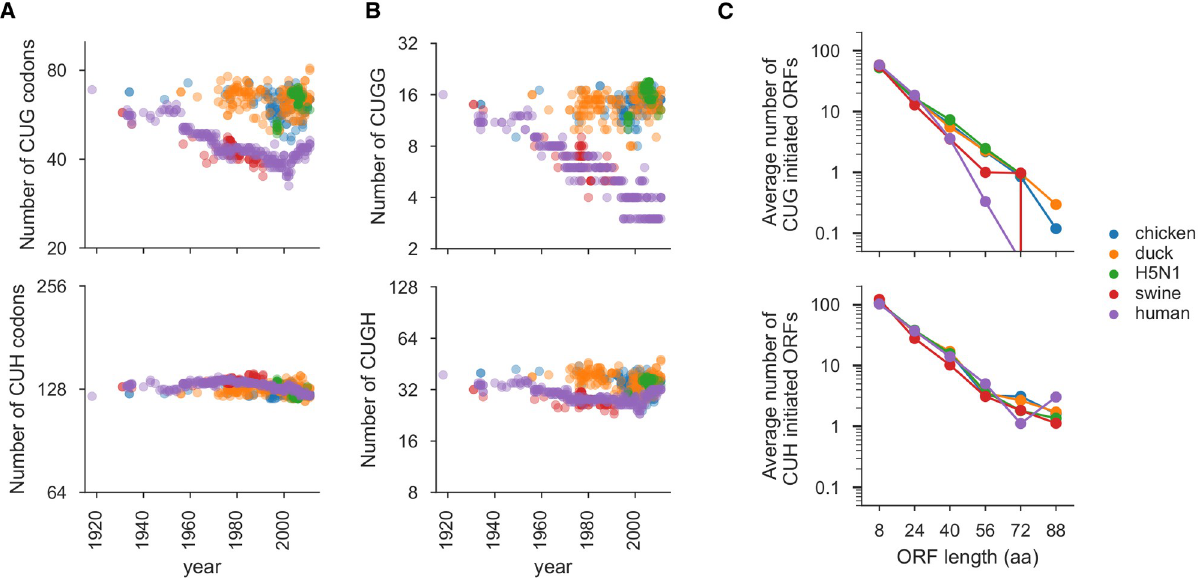
Fig 1. Evolutionary selection against CUG codons in mammalian influenza. (A) Number of CUG (upper panel) and CUH (where H is A, U or C, lower panel) codons in reading frame 0 of viral genes from human, avian, and swine influenza sequences. X-axis indicates the year that the viral sequence was isolated. (B) Number of in-frame CUGG (upper panel) and CUGH (lower panel) motifs in reading frame 0 of the viral genes. (C) Average length in codons of CUG- and CUH-initiated ORFs in reading frames 1 and 2 of the viral genes for sequences isolated between 1970 and 2011. Lines crossing the x-axis in this panel indicate that the counts go to zero (which cannot be explicitly shown on a log scale). All plots show data only for the genes on the PB2, PA, NP, NS and M segments, since these are the segments that have not re-assorted in human lineages derived from the 1918 virus.